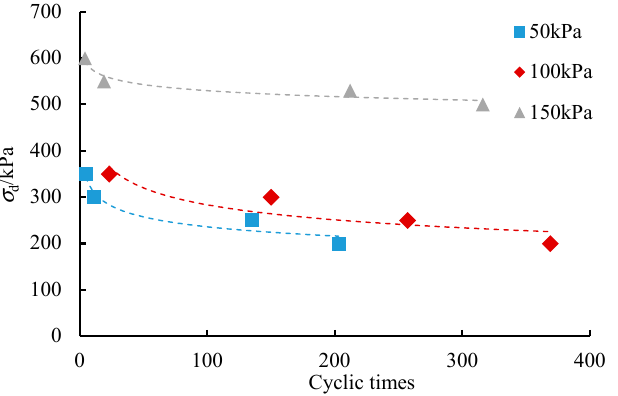
Figure 6. Dynamic strength–critical cycle number under various confining pressures.